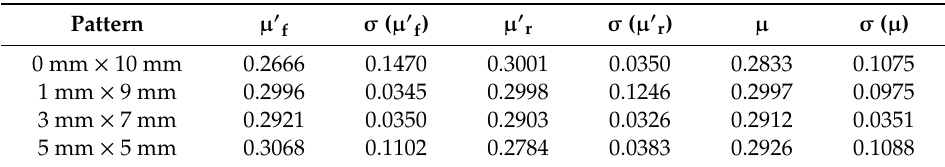
Table 1. Means and standard deviations of forward, reverse and averaged coefficients of friction for the different patterns.